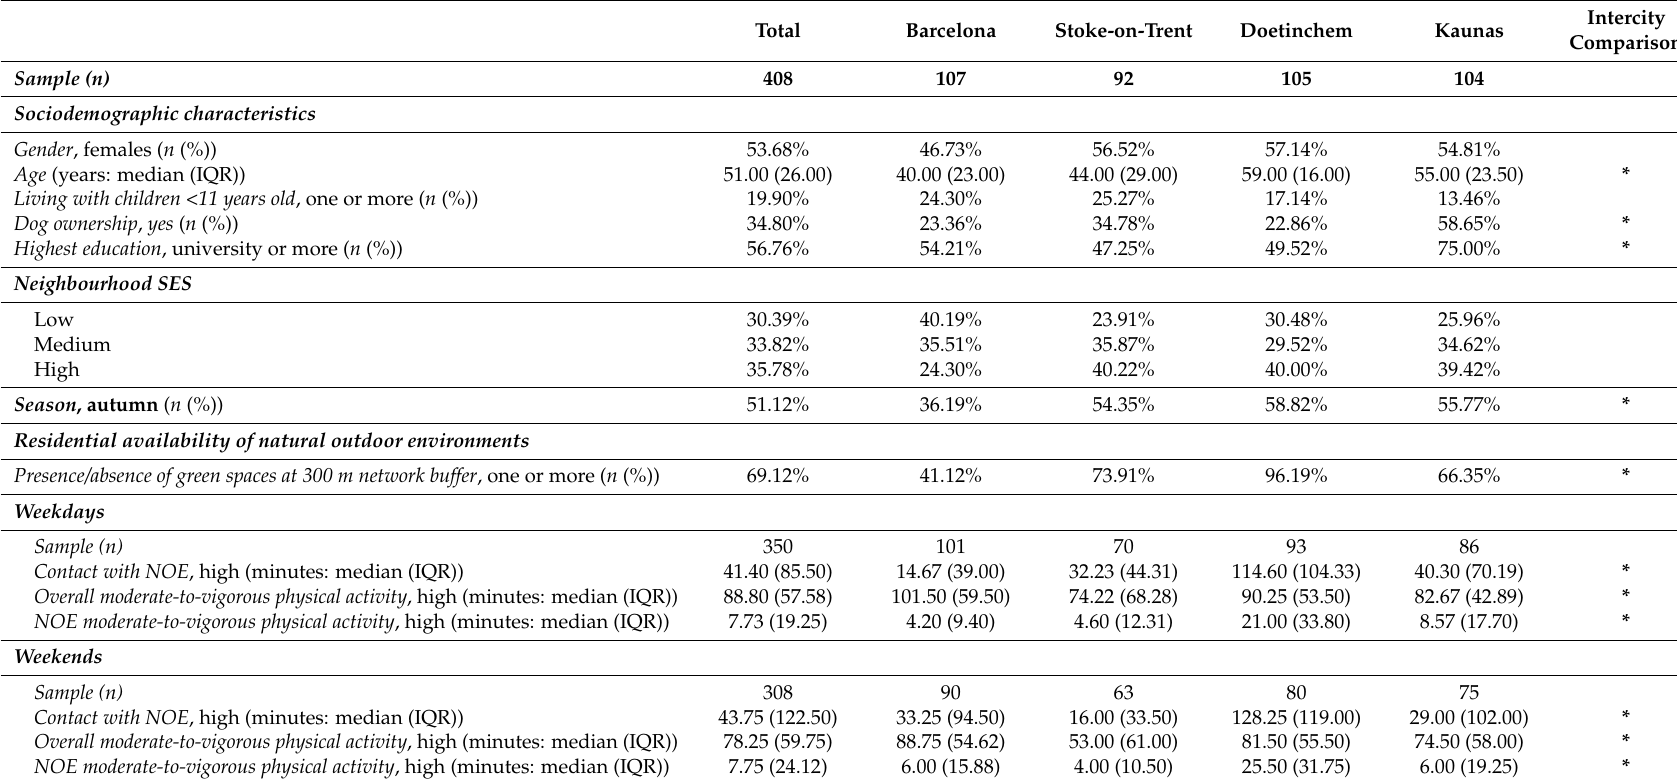
Table 1. Sample description and intercity comparisons using Kruskal-Wallis/Chi2